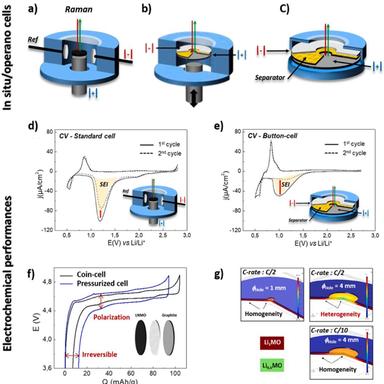
.1. Different designs of custom-made in situ / operando Raman spectro-electrochemical half-cells with quartz windows: (a) beaker cell with large volume of electrolyte (Li metal counter and reference electrode); (b) pressurized cell with two possible configurations (not represented) enabling to observed the bottom electrode through holes in top electrode and separator (or the back of the top electrode through a metal mesh used as electrical contact – not represented); (c) coincell like spectro-cell. Spectro-